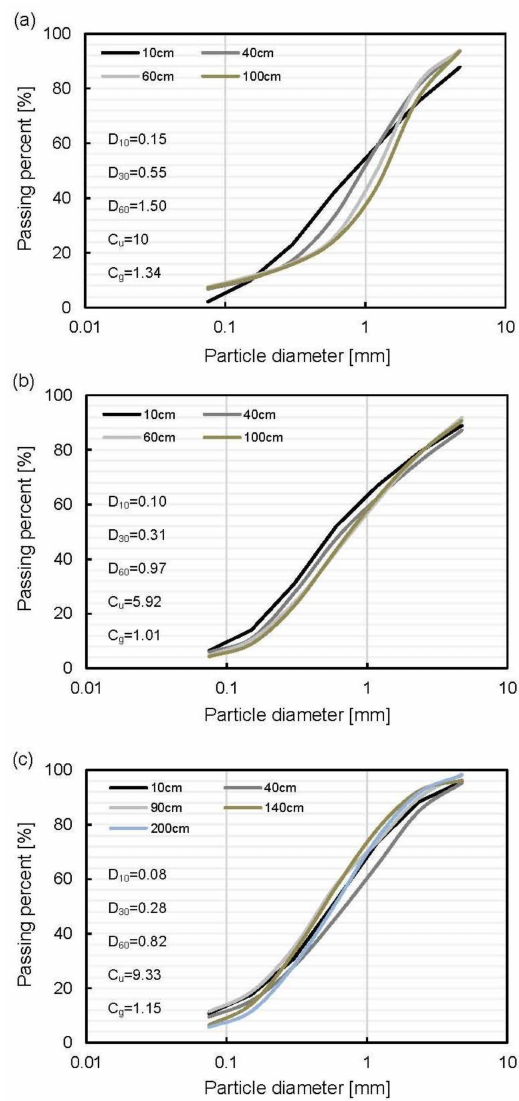
Figure 2. Sieve test results: ( a ) bottom stream (point A in Figure 1); ( b ) middle stream (point B); ( c ) top stream (point C). D 10 , D 30 , and D 60 denote the diameters at passing percentages of 10, 30, and 60%, respectively. C u and C g are coefficients of uniformity and curvature,